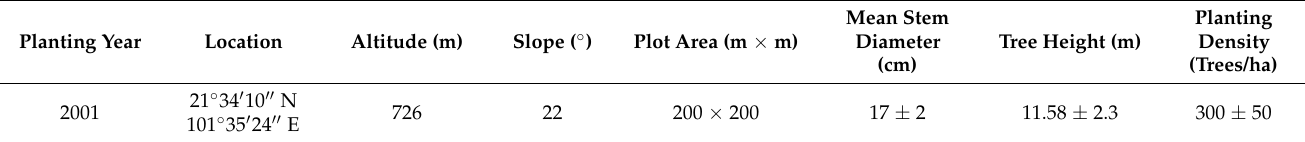
Table 1. Characteristics of the rubber plantation and the experimental site.